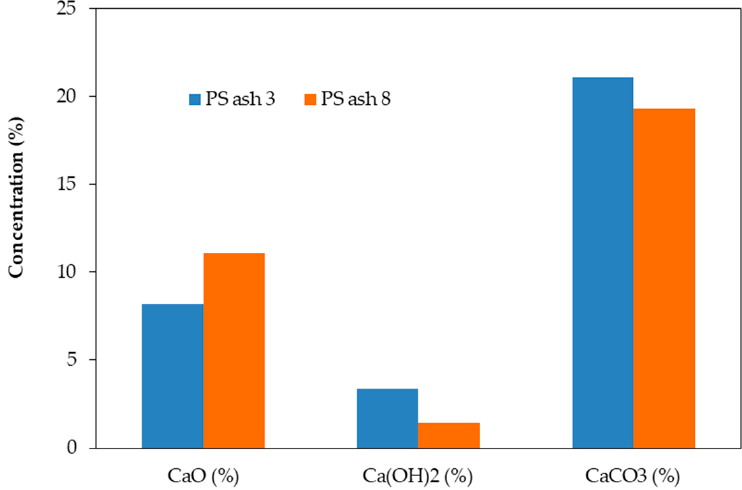
Figure 2. Calcium compound concentrations in PS ash 3 and PS ash 8